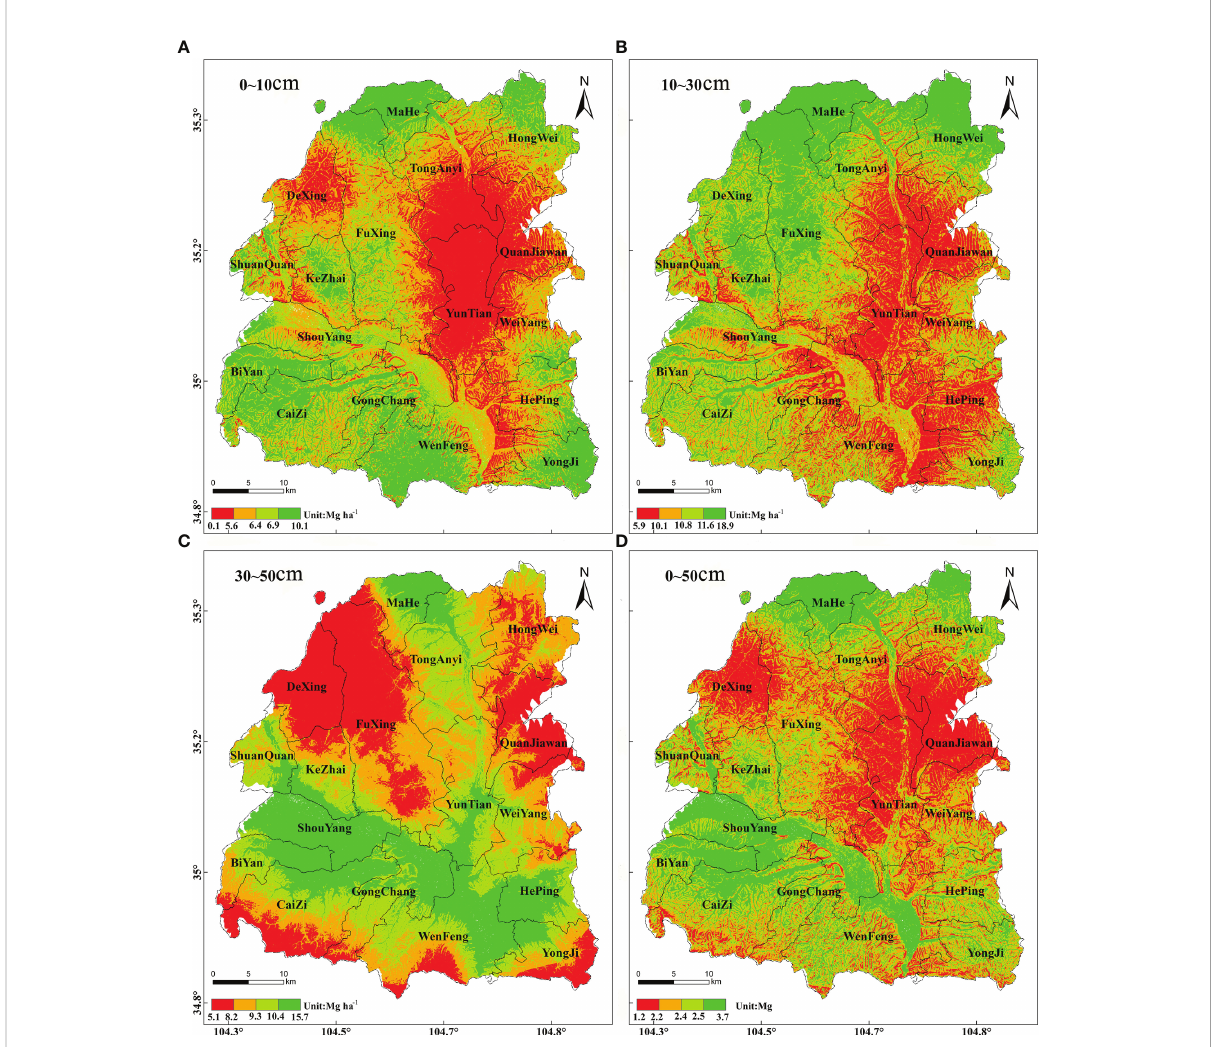
FIGURE 2 Interpolation results of the principal component regression Kriging model of SCOD in the (A) 0 – 10 cm soil layer, (B) the 10 – 30 cm soil layer, and the (C) 30 – 50 soil layer; and (D) soil organic carbon storage in the 0 – 50 cm soil